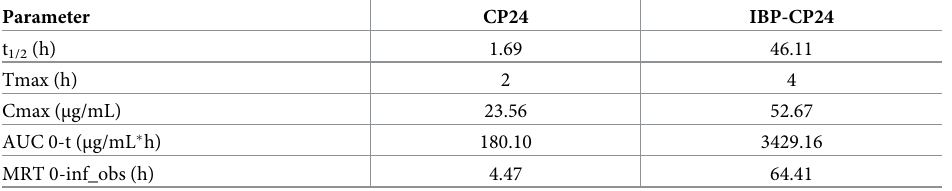
Table 2. Pharmacokinetic parameters of CP24 (n = 2) and IBP-CP24 (n = 3) in rhesus monkeys.